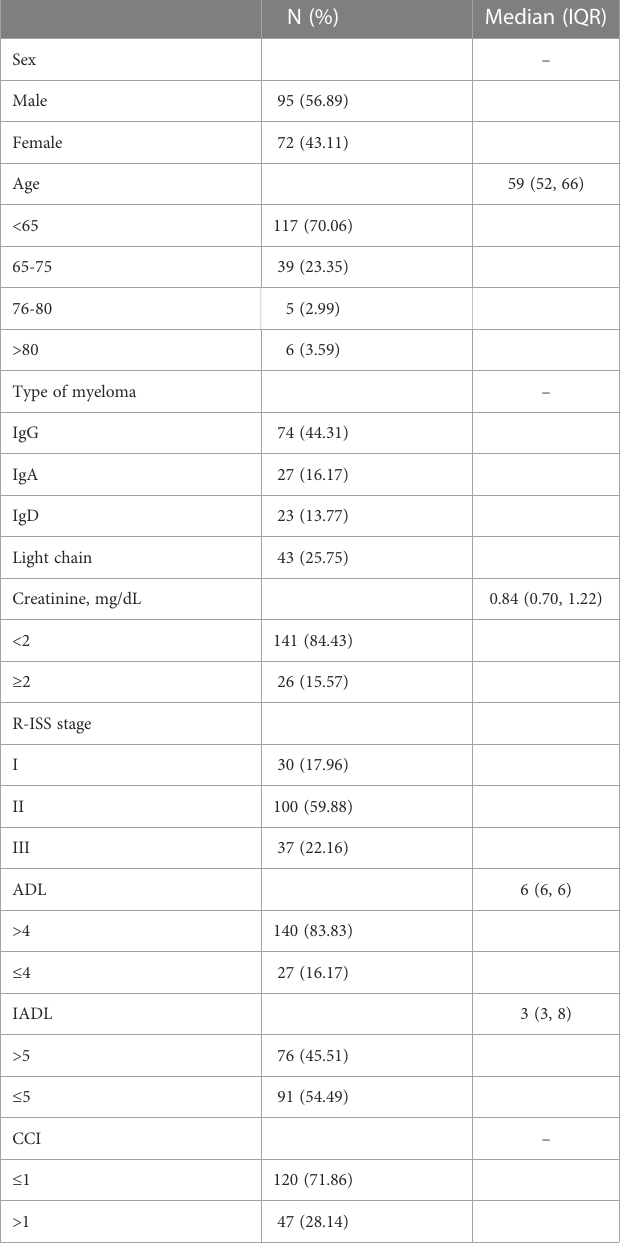
TABLE 1 Baseline disease characteristics of the patients